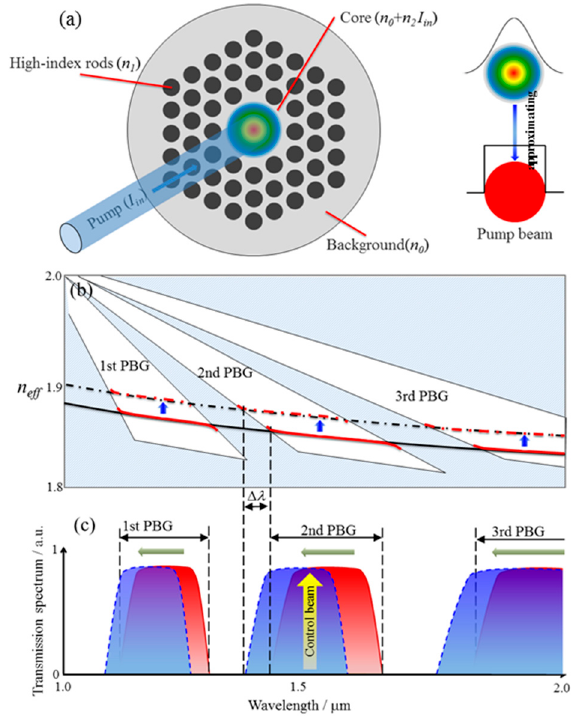
Figure 1. ( a ) Control beam with intensity I in transmitting in the core of an all-solid PBGF. ( b ) BPG regions appear from 1.0 μ m to 2.0 μ m. ( c ) Schematic diagram of the transmission shift induced by OKE in an all-solid tellurite PBGF.